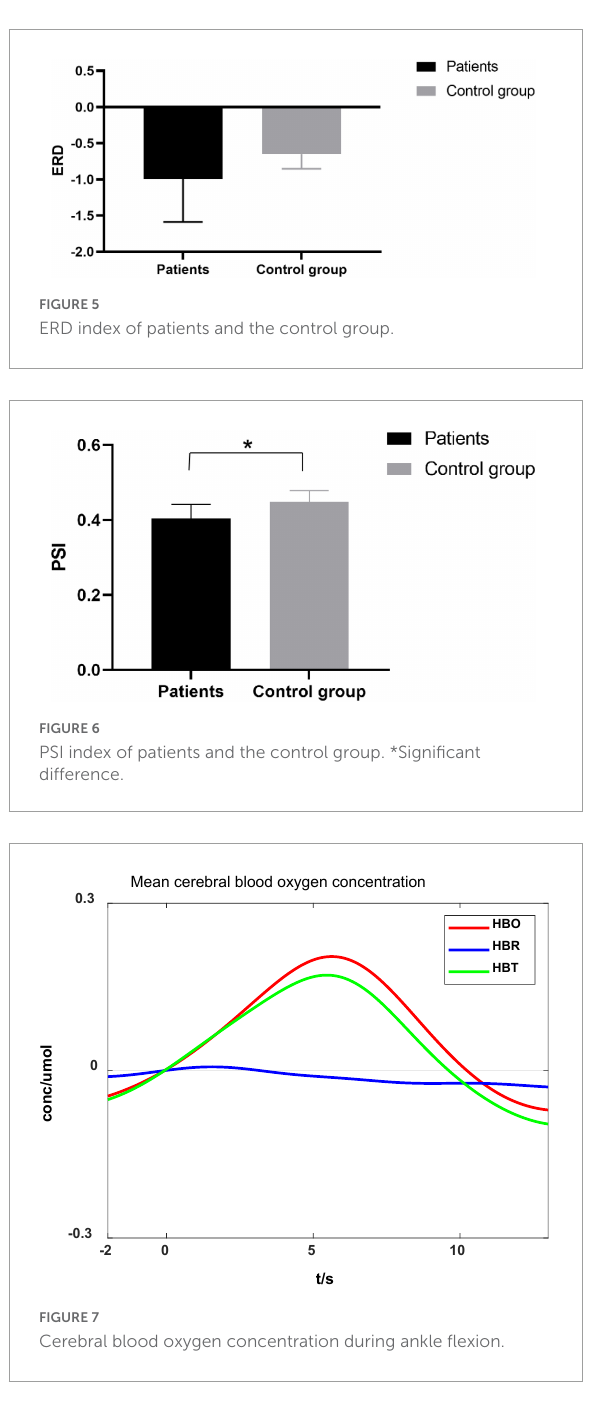
fNIRS channels. The area between the average HBO curve and the horizontal axis predicted the BBS scale